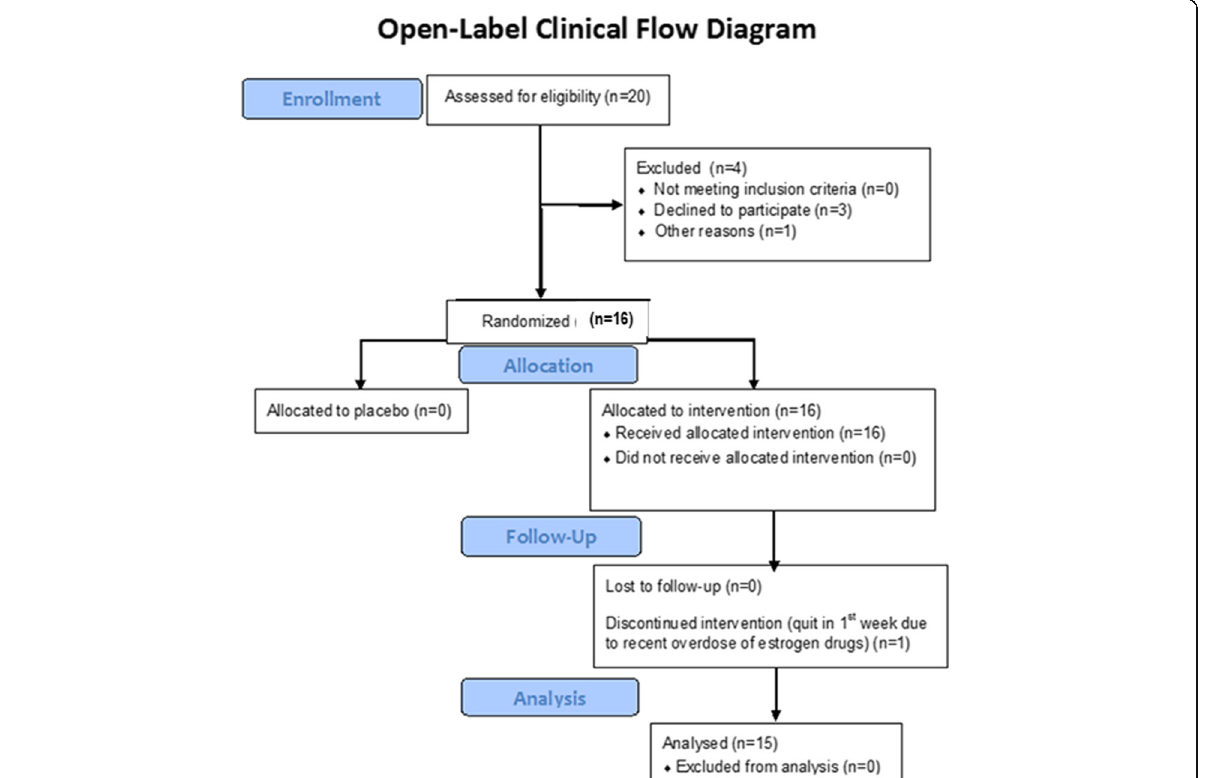
Fig. 1 Participant Clinical Flow Diagram: The flow of subjects through each stage of the SC100+ clinical study is shown in the Clinical Flow